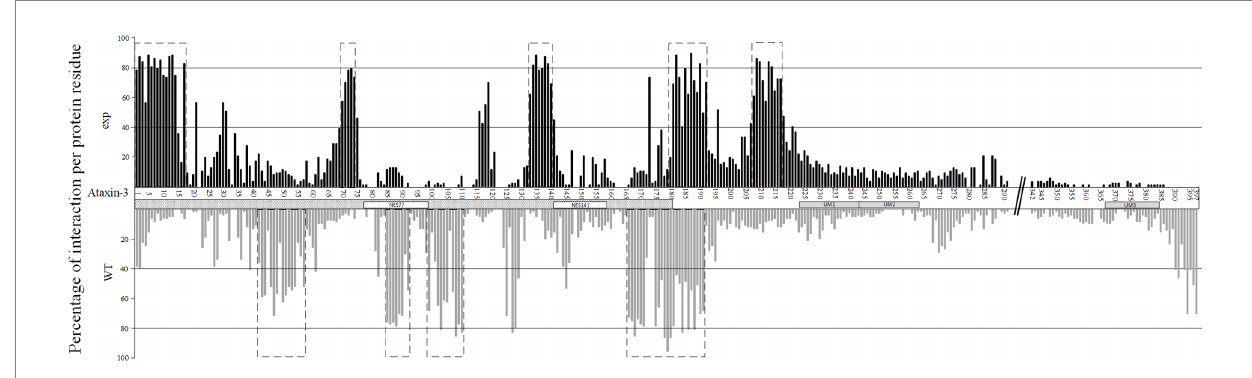
FIGURE 5 Percentage of interaction per protein residue at the exp (upper panel, in black) and wt (lower panel, in gray) ataxin-3 forms. Dotted boxes represent regions of interaction where more than 50 percent of the proteins show interaction with the two ataxin-3 forms. The Josephin domain (JD) is assigned as a dotted box, while the NES77 and NES141 regions are marked with white boxes. UIM regions are also assigned with gray boxes. The polyQ region is assigned with